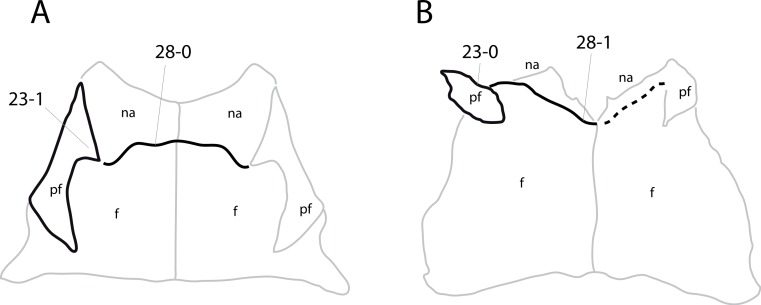
Skull roof of Diplodocus sp. CM 11161 (A; based on Wilson & Sereno, 1998) and Limaysaurus tessonei MUCPv-205 (B; based on Calvo & Salgado, 1995) in dorsal view.Note the anteromedial hook in the prefrontal of CM 11161 (A; C23-1), and the differently shaped frontal-nasal suture (straight to anteriorly bowed in A, C28-0; bowed posteriorly in B, C28-1). Abb.: f, frontal; na, nasal; pf, prefrontal. Scaled to the same skull roof length.